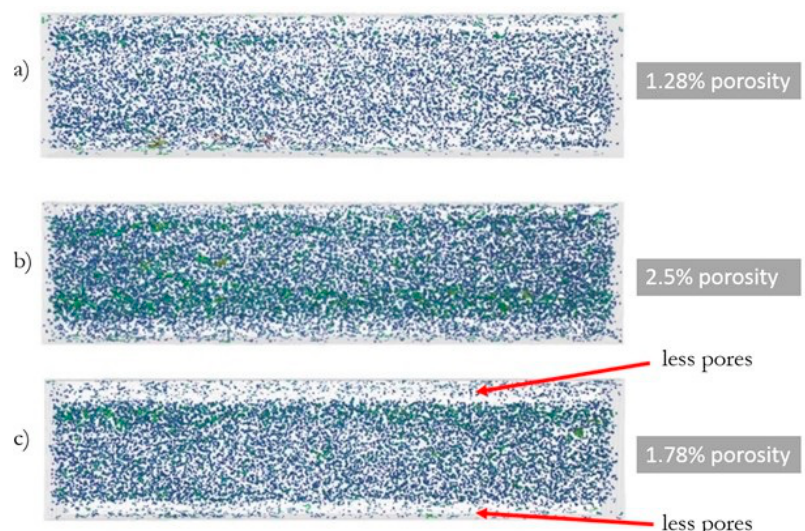
Figure 2. Images of samples based on their cross-sections, formed at a variable injection rate: ( a ) 10, ( b ) 35, and ( c ) 70 cm 3 /s.